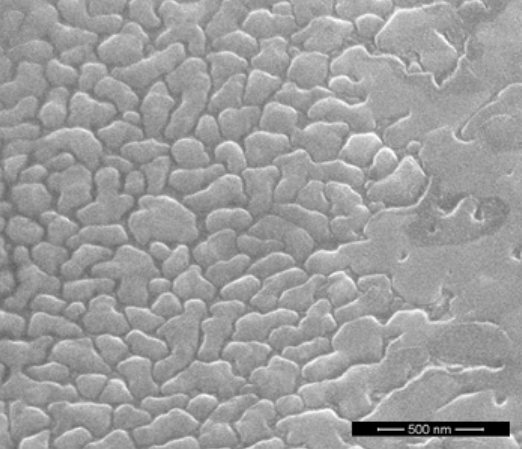
Fig.1 – FEG-SEM micrograph of the sample deposited on c-plane (0001) sapphire substrates, heated at 600 °C and with working pressure of 15 mTorr showing Co islands randomly distributed and some are